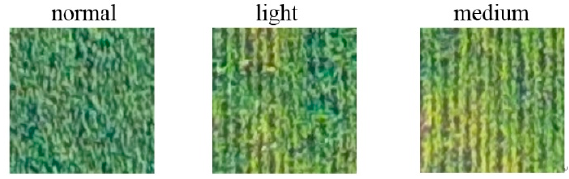
Figure 6. Field images in different HLB disease categories.